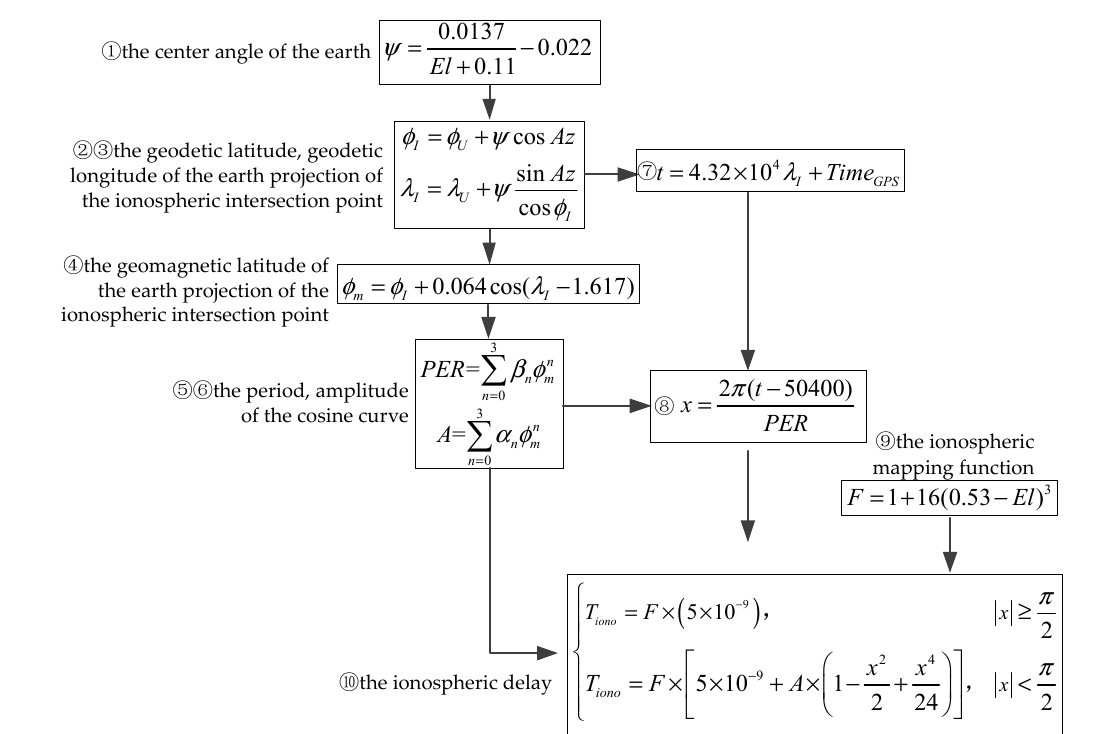
Figure 7. The calculation steps of the ionospheric delay.